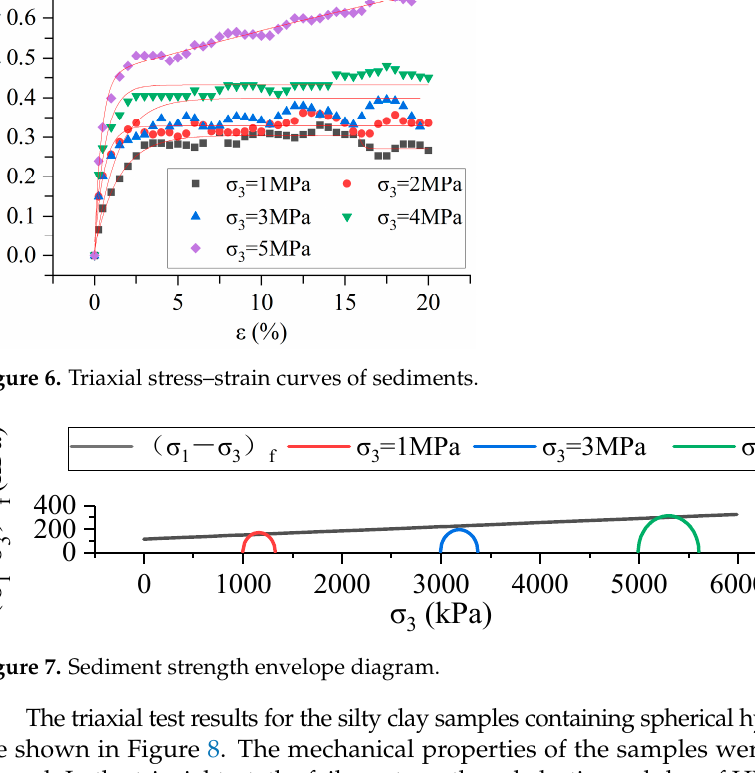
Figure 8. Triaxial stress–strain curves of sediments containing spherical hydrates ( 𝑟 = 5𝑚𝑚 ). Under the same experimental conditions, the results for the sediment samples con- taining spherical hydrates ( 𝑟 = 8.5 𝑚𝑚 ) are shown in Figure 9. With the increase in hy- drate radius, the mechanical properties of the samples improved, while the curve trends are similar to those of the sediments containing spherical hydrates ( 𝑟 = 5 𝑚𝑚 ). When the confining pressure was greater than 3 MPa, the mechanical properties of the samples in this test also decrease. The reason may be local stress concentrations caused by spherical hydrate occurrence in sediments. According to Saint-Venant’s Principle, the range of local stress concentrations is twice the diameter of spherical hydrates, and they overlap as shown in Figure 10. Under the condition of high confining pressure, the overlapping range of local stress concentrations may lead to the formation of micro-fractures in sedi- ments, resulting in a decrease in the strength of samples.